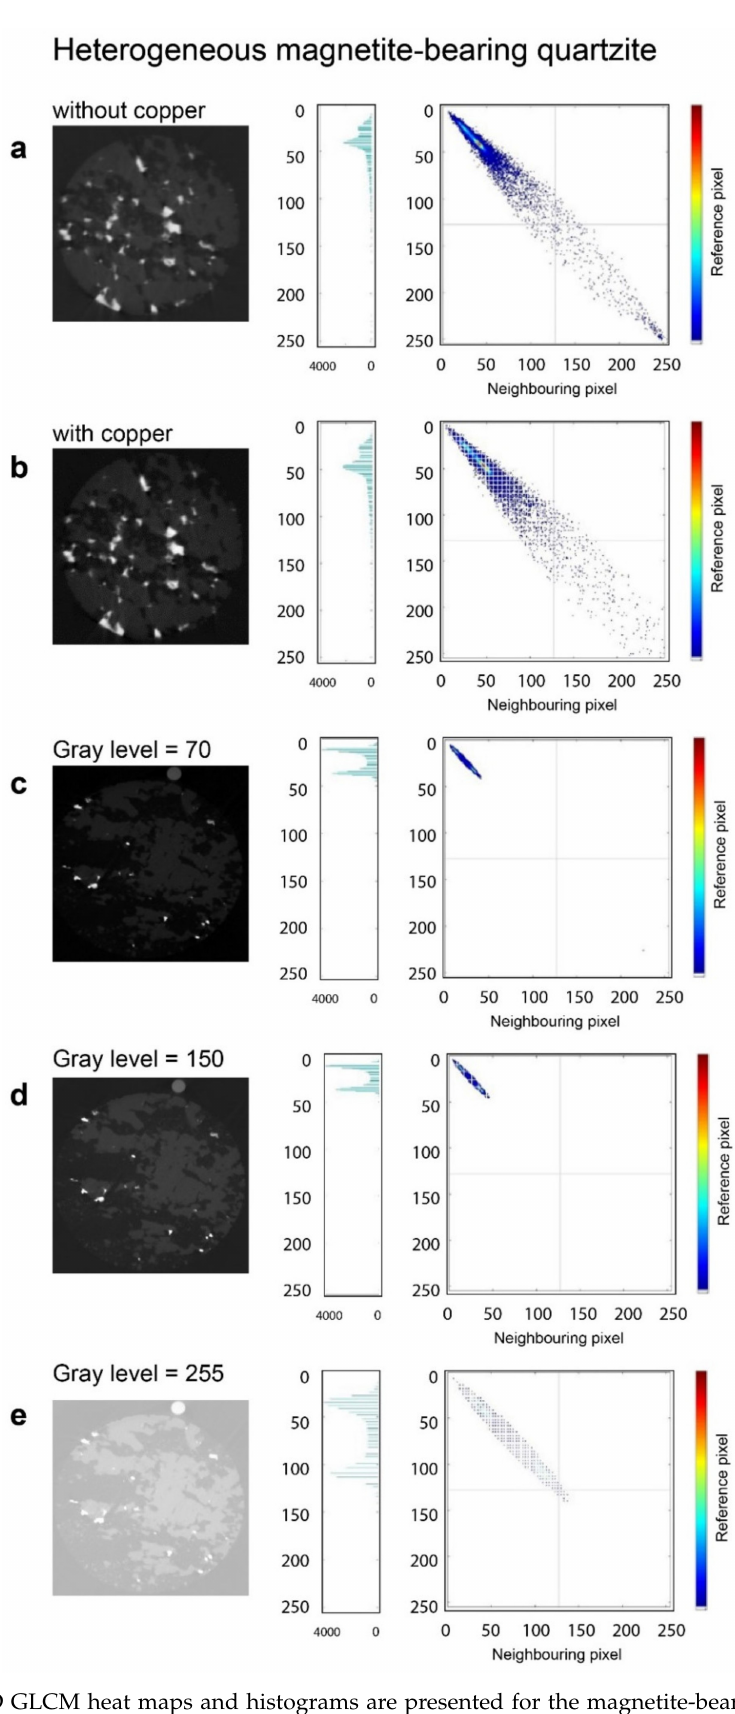
Figure 7. 3D GLCM heat maps and histograms are presented for the magnetite-bearing quartzite scanned without and with the copper wire ( a , b ). Examples of the changes in gray values where the copper wire is adjusted to 70, 150 and 255 are given respectively ( c – e ), and how these changes a ff ect the 3D GLCM heat maps and